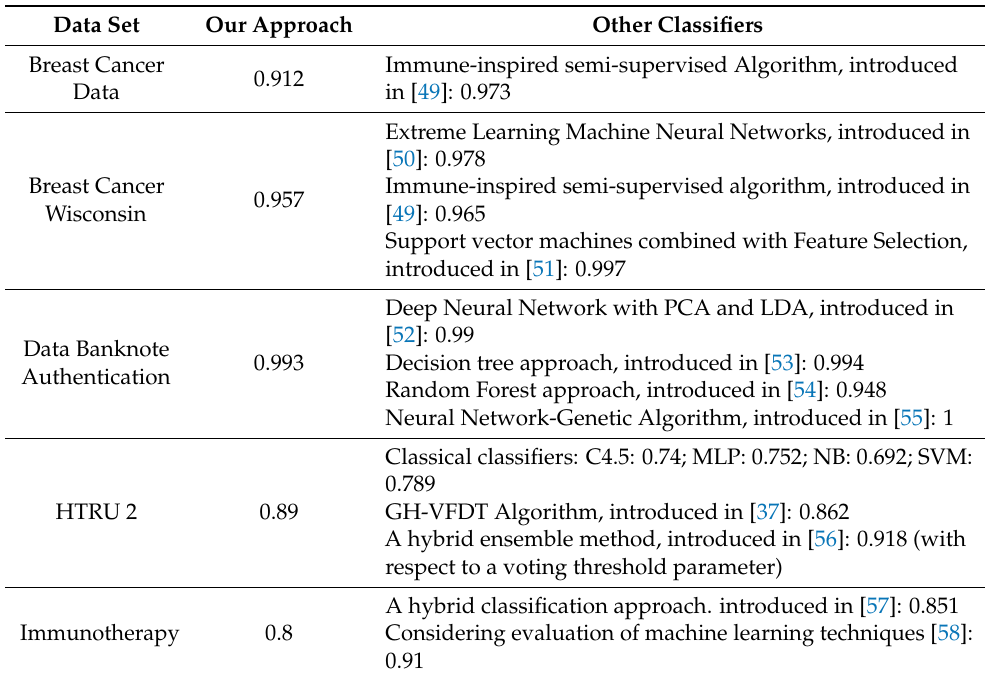
Table 7. Comparison regarding other classifiers with respect to the F-score